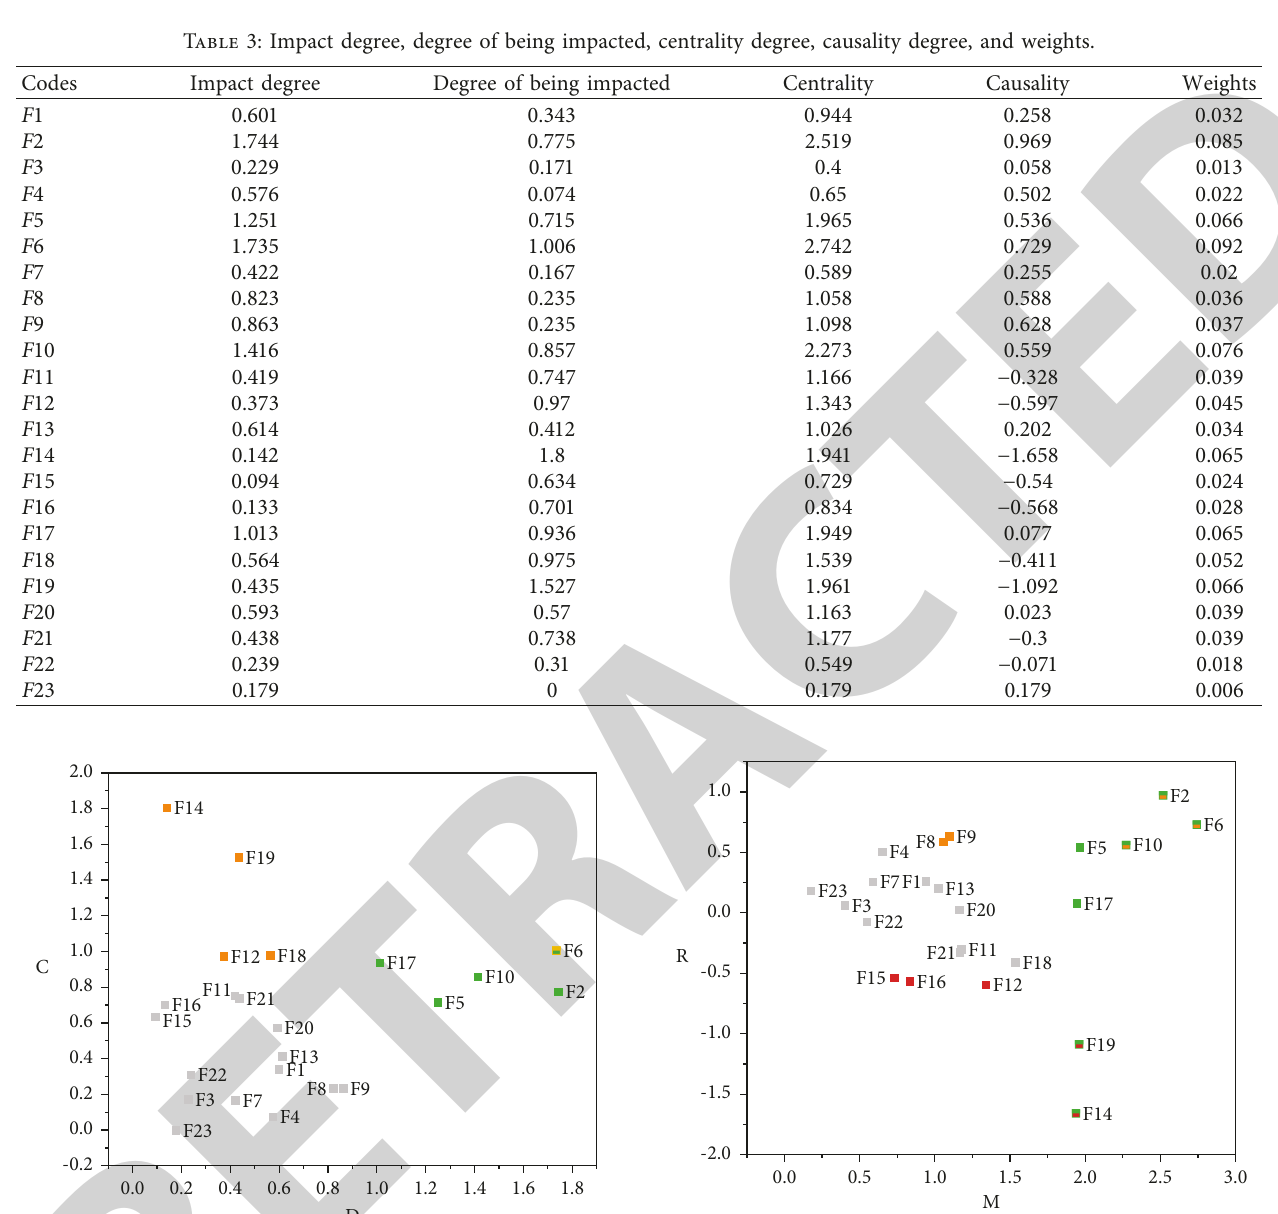
Figure 5: Centrality-causality